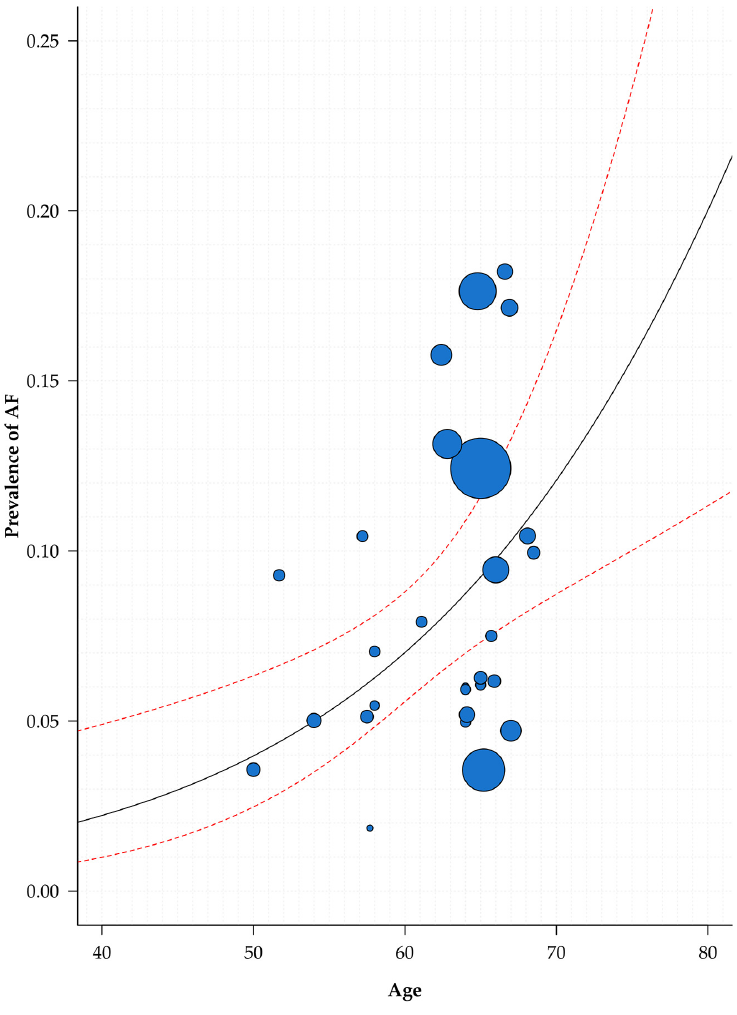
Figure 2. Relationship between age and AF prevalence in COVID-19 patients. Legend: AF = atrial fibrillation.